Question: Condense the content of this figure into a single sentence.
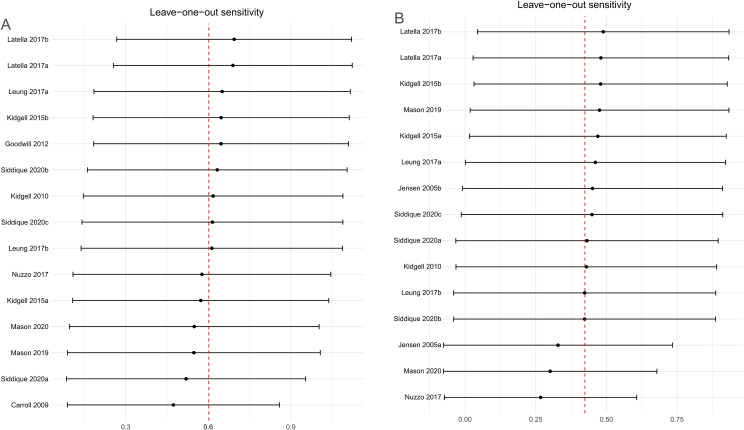
Answer: Sensitivity analysis. (A) cortical excitability sensitivity analysis; (B) motor performance sensitivity analysis.